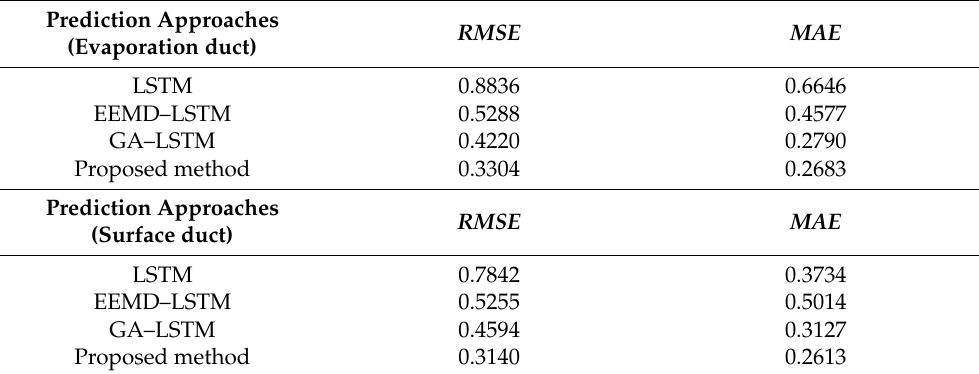
Table 8. Error estimated results of prediction